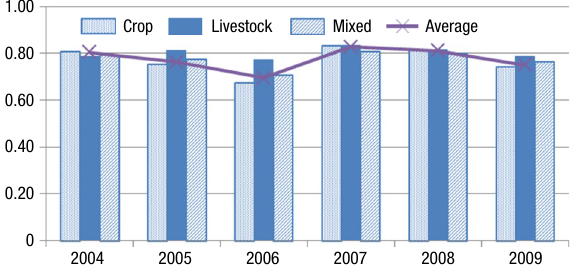
Fig. 1. Mean TE scores across different farming types,